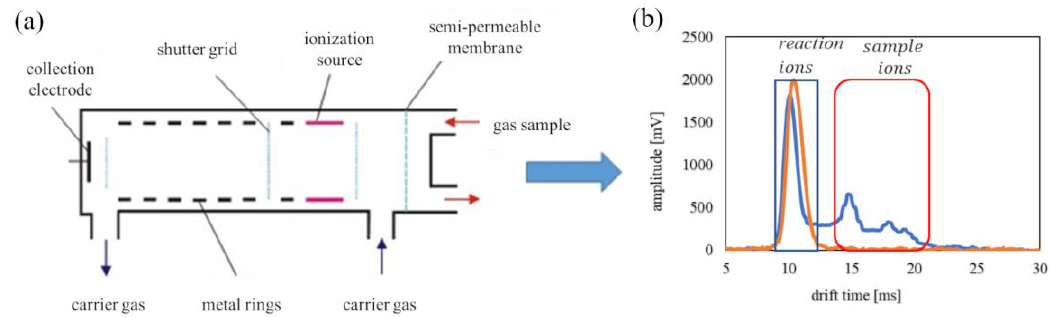
Figure 3. ( a ) IMS with the DT IMS detector principle of operation and ( b ) an exemplary drift time spectra for hydronium ions.